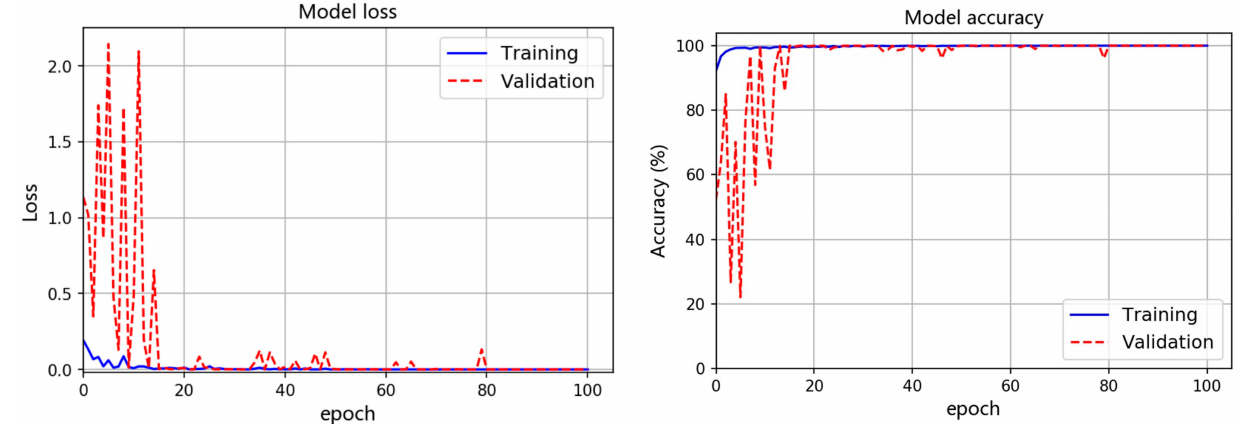
Figure 9. A typical training–validation curve showing the comparison of the accuracy and loss during the training and validation of InceptionTime network using raw AE time series data.